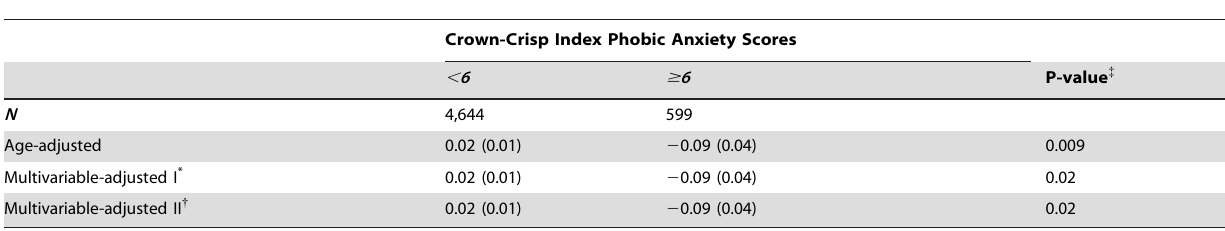
Table 3. Least-squares mean leukocyte telomere length z-scores (standard errors), by high phobic anxiety.